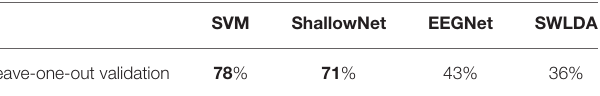
TABLE 4 | Comparison of performance of classification methods with power spectra features of EEG2.